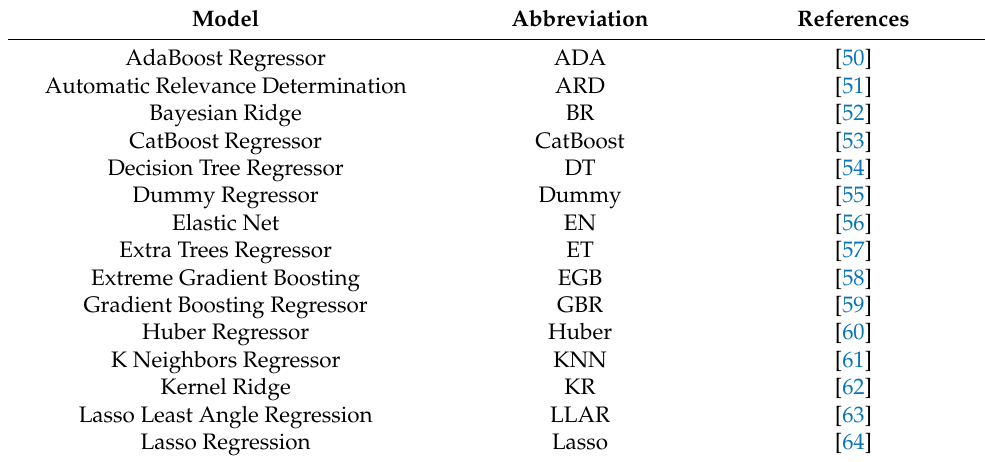
Table 5. Machine learning